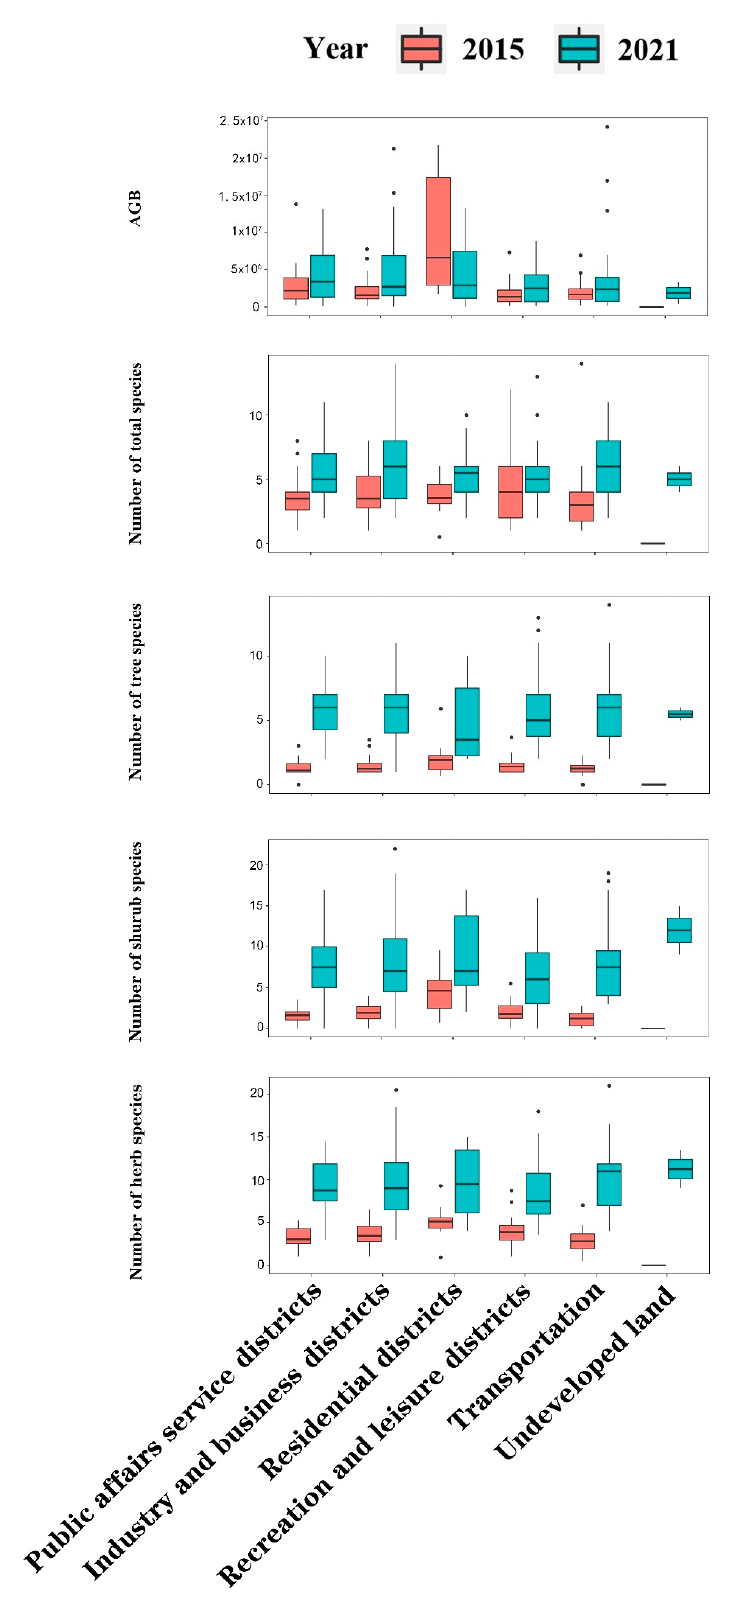
Figure 2. Boxplots of AGB and the number of total, tree, shrub and herb plant species in primary UFUs in 2015 and 2021. The black dots in the graph represent extreme